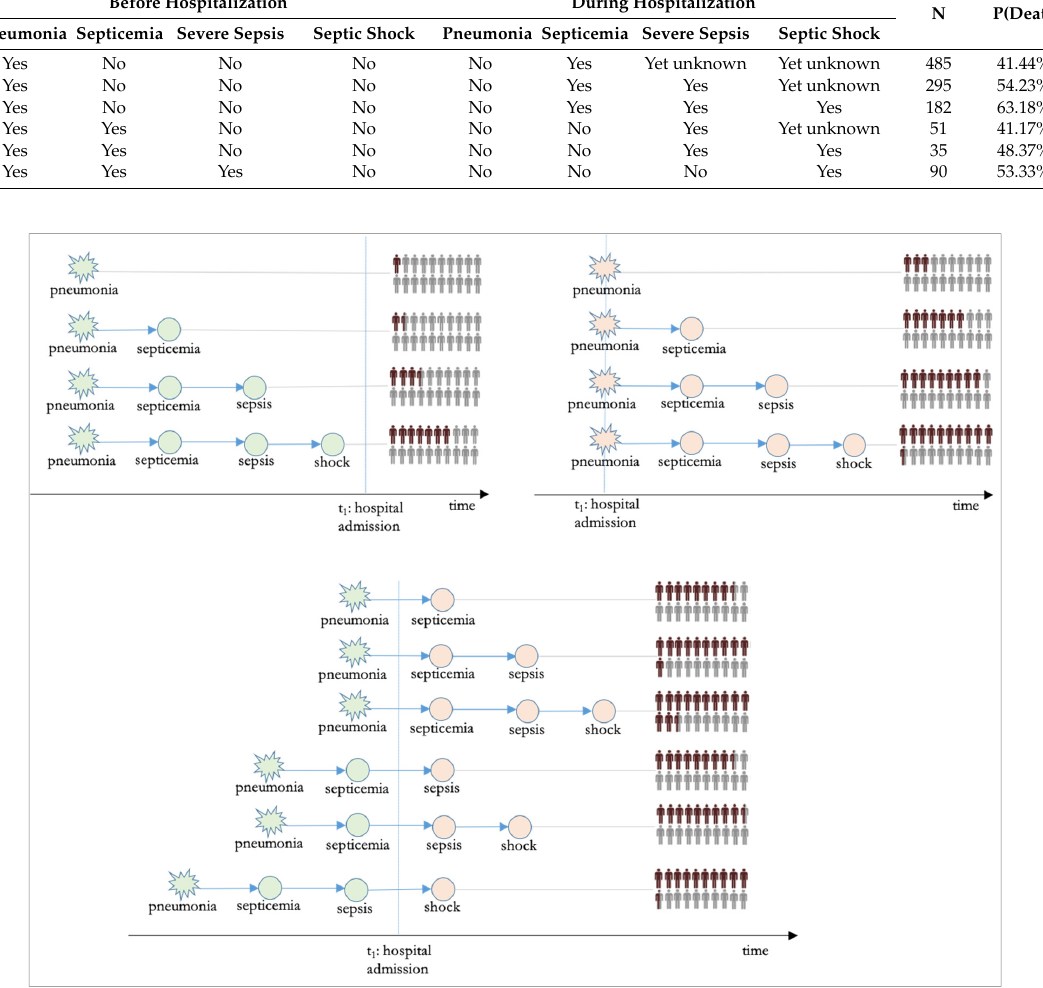
Figure 3. Infographic of the proportion of deaths for each pneumonia-induced bloodstream infection scenario.